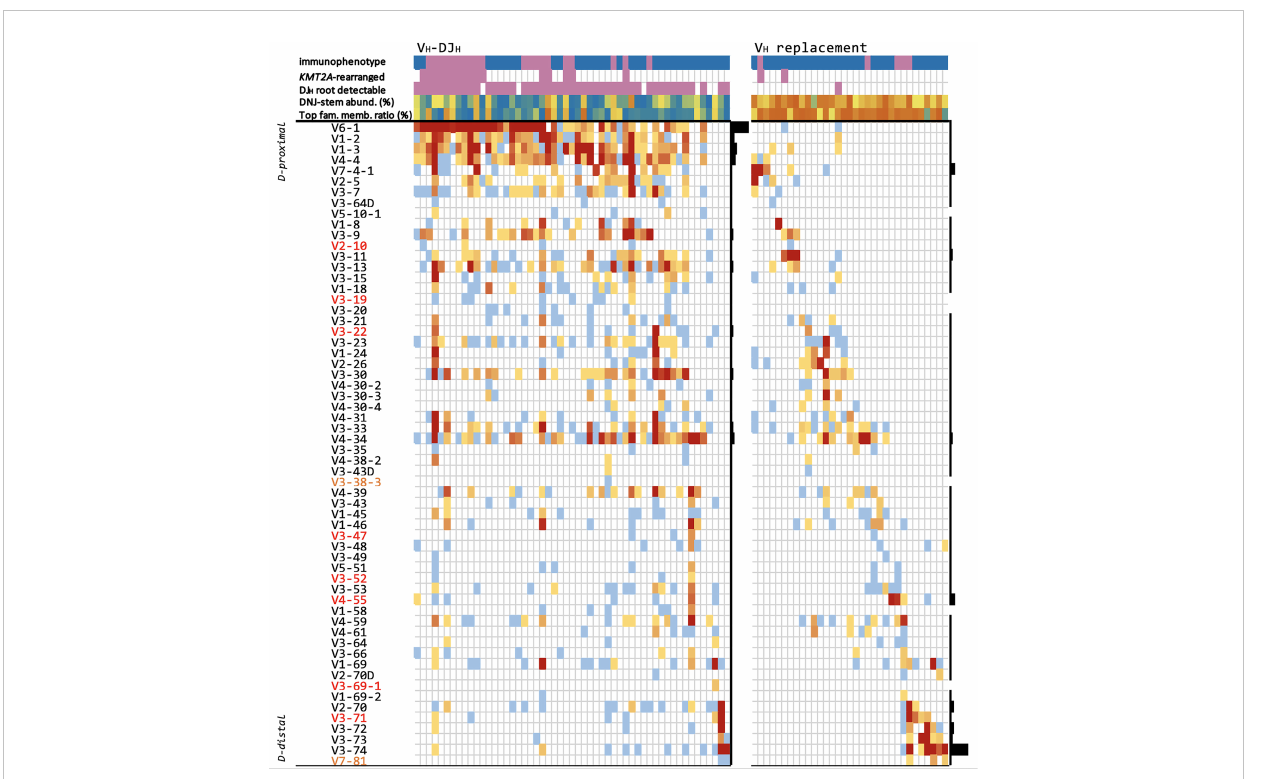
FIGURE 5 Evolving DNJ-stems in the diagnostic cohort. Each column represents one representative evolving DNJ-stem in one patient, ordered by the locus order of the most frequent gene in that column. V H genes are sorted by their proximity to the D H genes (proximal top to distal bottom), respectively; red gene names: pseudogenes, yellow: ORFs. Top rows: 1) immunophenotype: pro-B ALL purple, common-/pre-B ALL blue; 2) KMT2A molecular subtype status: KMT2Ar purple, non-KMT2Ar no color; 3) DJ H root with same DNJ-stem detectable (purple); 4) DNJ-stem abundance (% reads), blue to orange (0.2% to 97%); 5) most abundant family member clonotype to summed DNJ-stem abundance ratio, blue to orange (0.01 to 0.99). Heatmap cells are colored by number of DNJ-stem family members featuring each gene, blue to red (1 to 418); black bar plots on the right of each mechanism group visualize each gene ’ s relative frequency in that group.